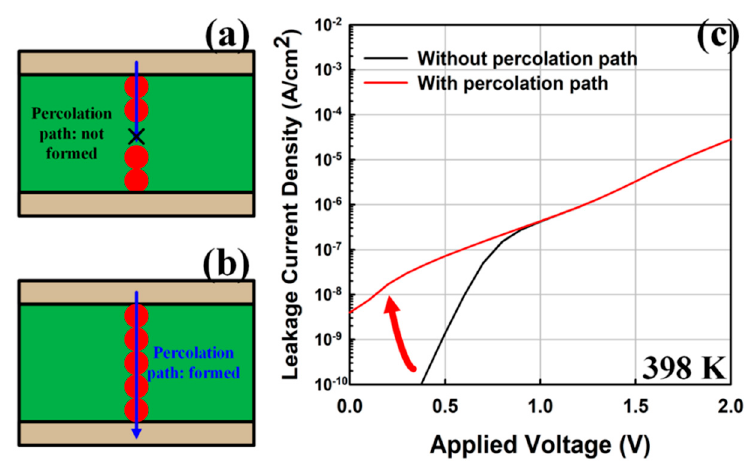
Figure 3. Calculation of I LIMIT assuming the percolation path is ( a ) not formed or ( b ) formed; ( c ) corresponding leakage current densities. The red circles represent traps, while the blue lines represent leakage current paths by trap-to-trap tunneling.